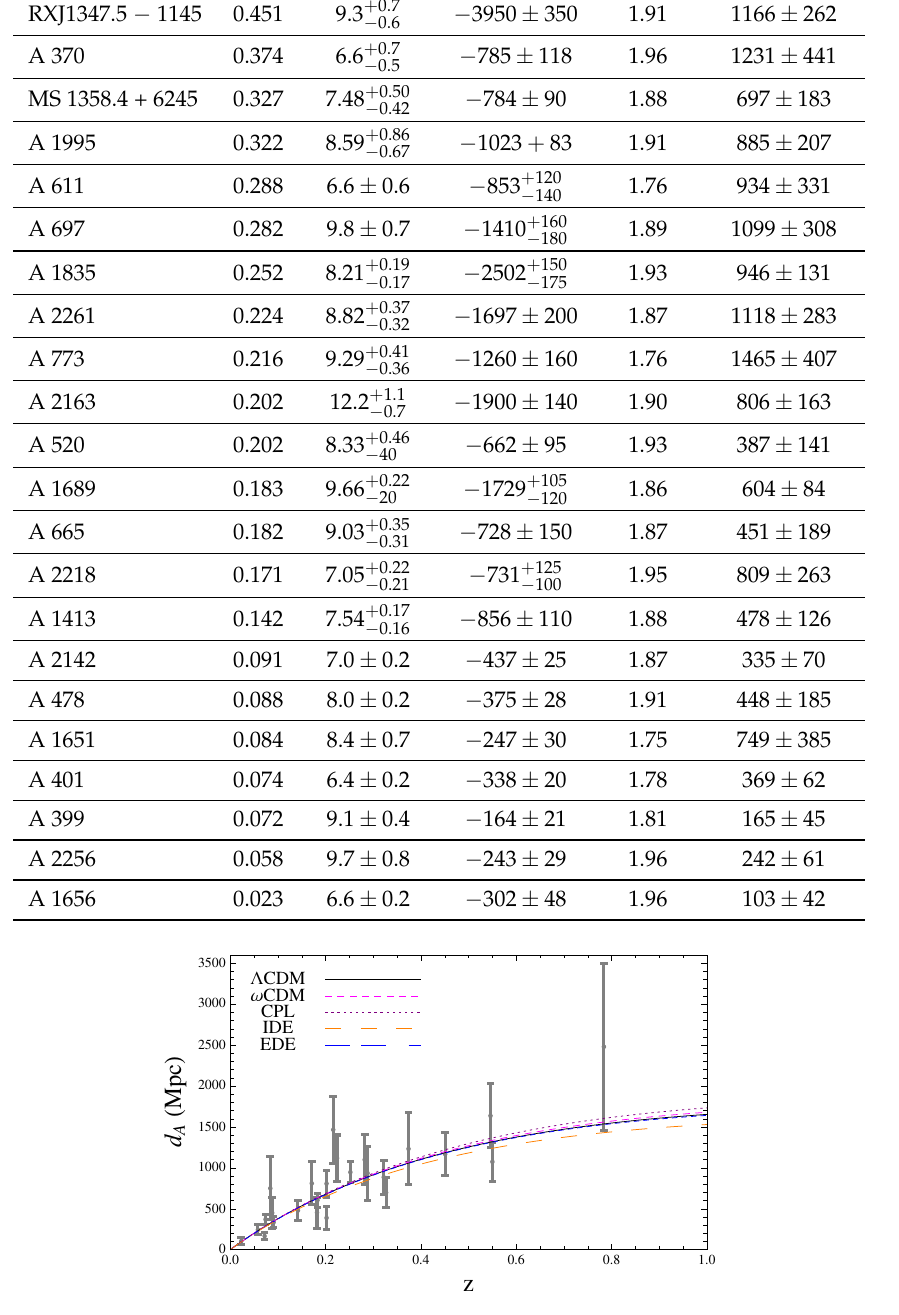
Figure A2. Angular diameter distance vs. redshift for different models with the best fit values from joint analysis (CMB + BAO + SNIa + d A + f gass + SGL) and a set of 25 data points from De Filippis et al. (Gray)